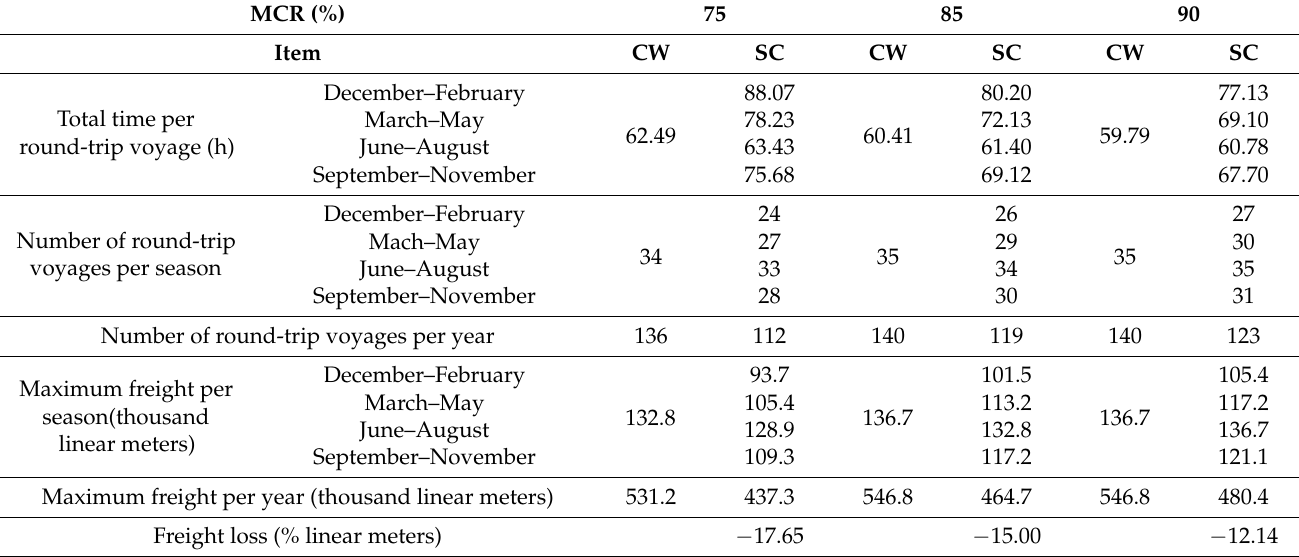
Table 12. Estimation of freight loss for Load Condition